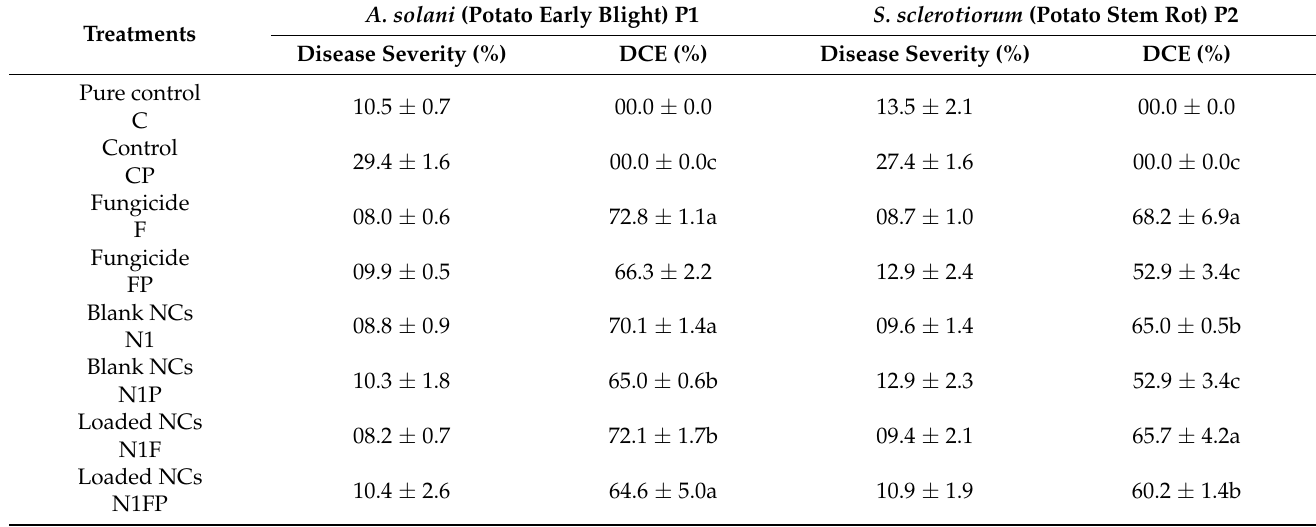
Table 3. The impact of CSGA NCs on disease effectiveness against early blight and stem rot in potato plants grown in pots.